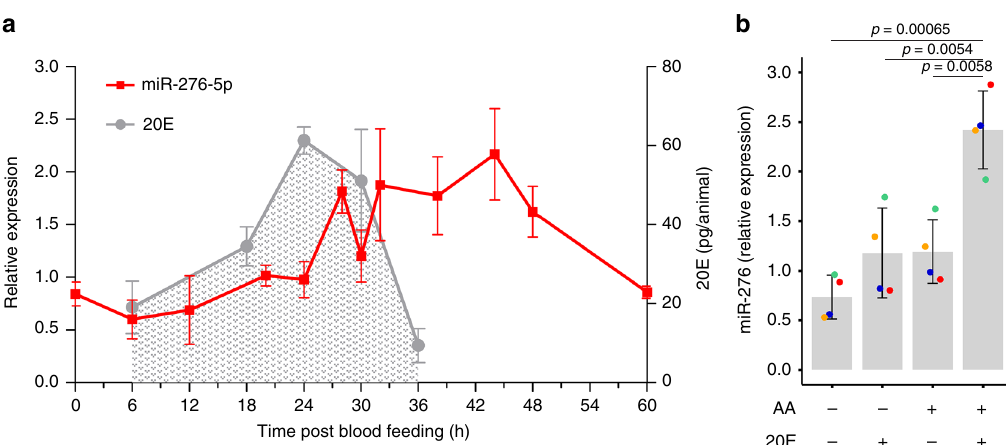
Fig. 1 Amino acid (AA) and steroid hormone (20E) signalling regulate miR-276 expression. a miR-276 (red) expression in the female fat body ( n = 10, N = 6) and 20-hydroxyecdysone (20E) titres (gray) in the mosquito females ( n = 9, N = 3) at different time points after blood feeding. The plots show mean ± SEM of independent experiments. b miR-276 expression in ex vivo fat body cultures of 3 – 4-day-old females ( n = 3, N = 4) after incubation with medium with or without amino acids (AA) and 20E. miRNA expression levels were normalized using the ribosomal protein RPS7 gene. Boxplots show the median with fi rst and third quartile, whiskers depict the min and max of independent experiments, colored dots show mean of each experiment. The statistical signi fi cance was tested by one-way ANOVA followed by Tukey ’ s post hoc test and the obtained p -values are shown above the horizontal lines ( n = number of mosquitoes pooled for each independent experiment; N = number of independent